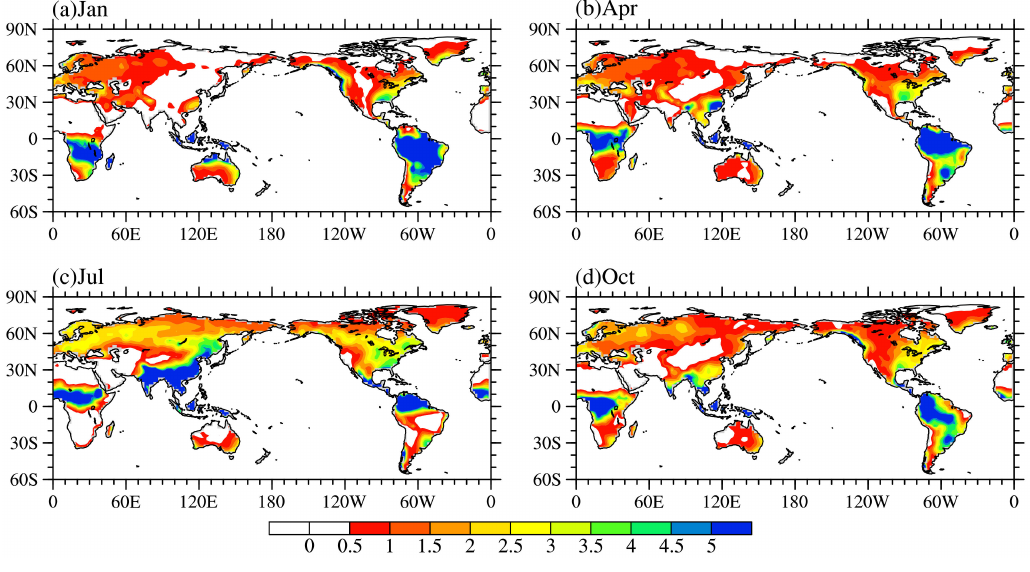
Figure 4. Spatial distribution of global precipitation (units: mm/d) in January ( a ), April ( b ), July ( c ) and October ( d ) derived from Qian atmospheric forcing data.